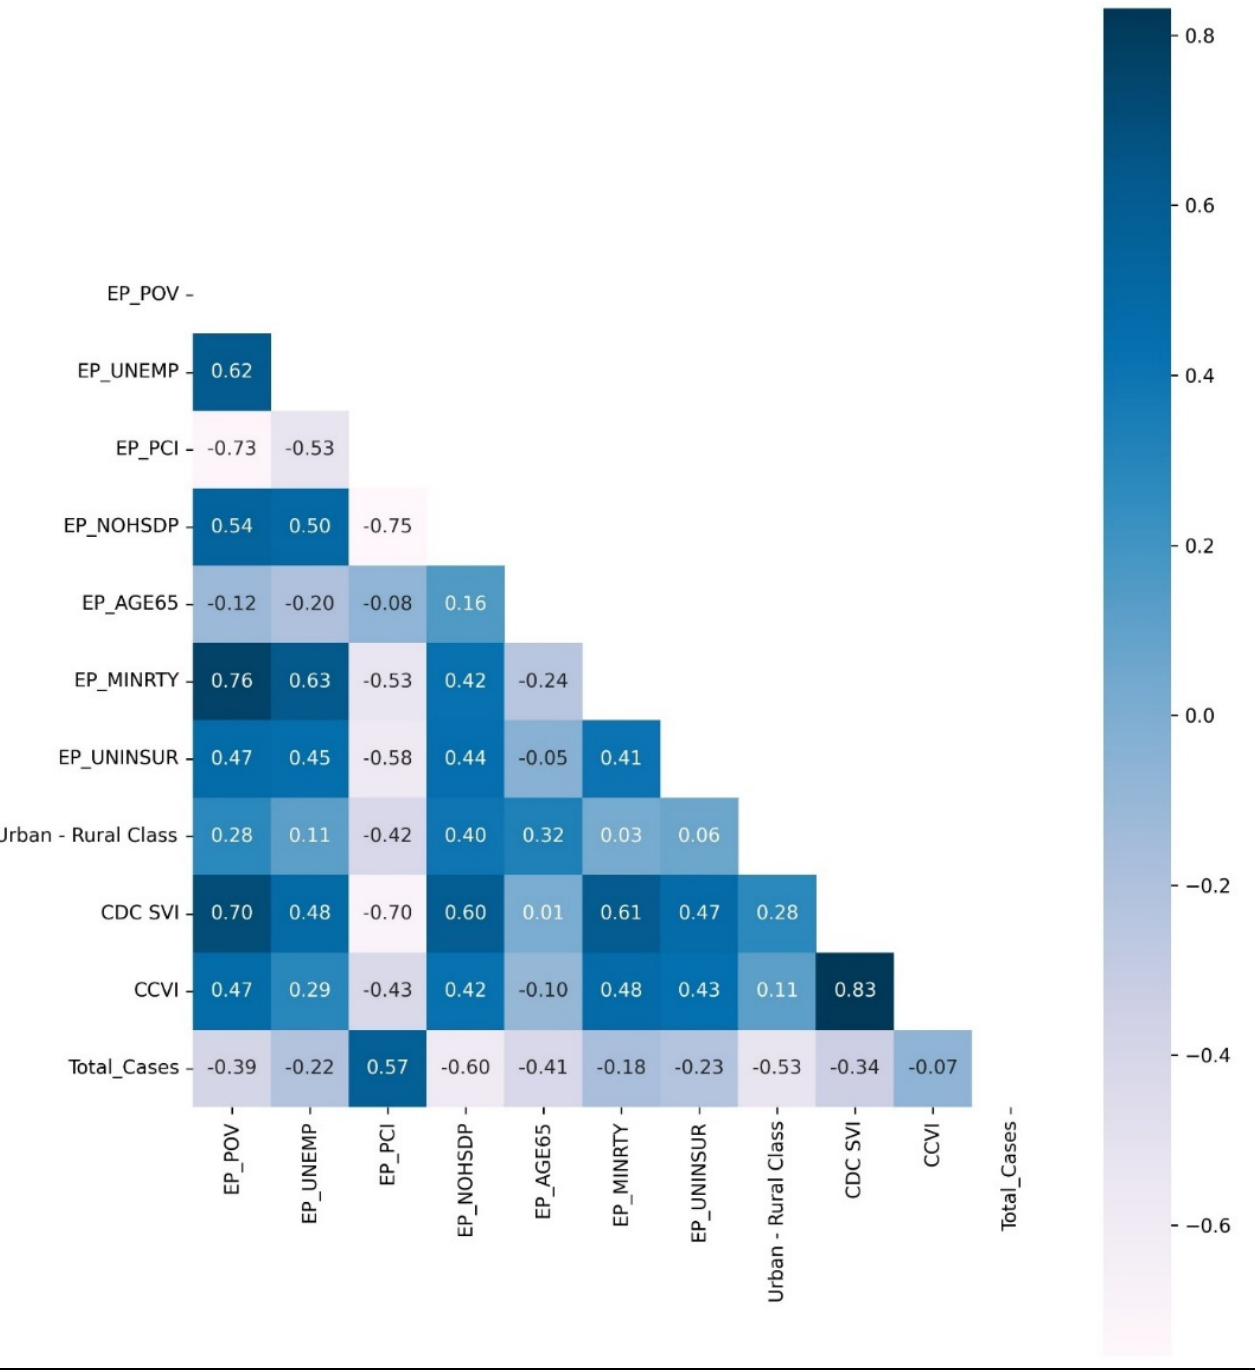
Figure 3. Heat Map Correlation Matrix of County-Level Features for County-Level Total Cases (Cumulative COVID-19 cases).